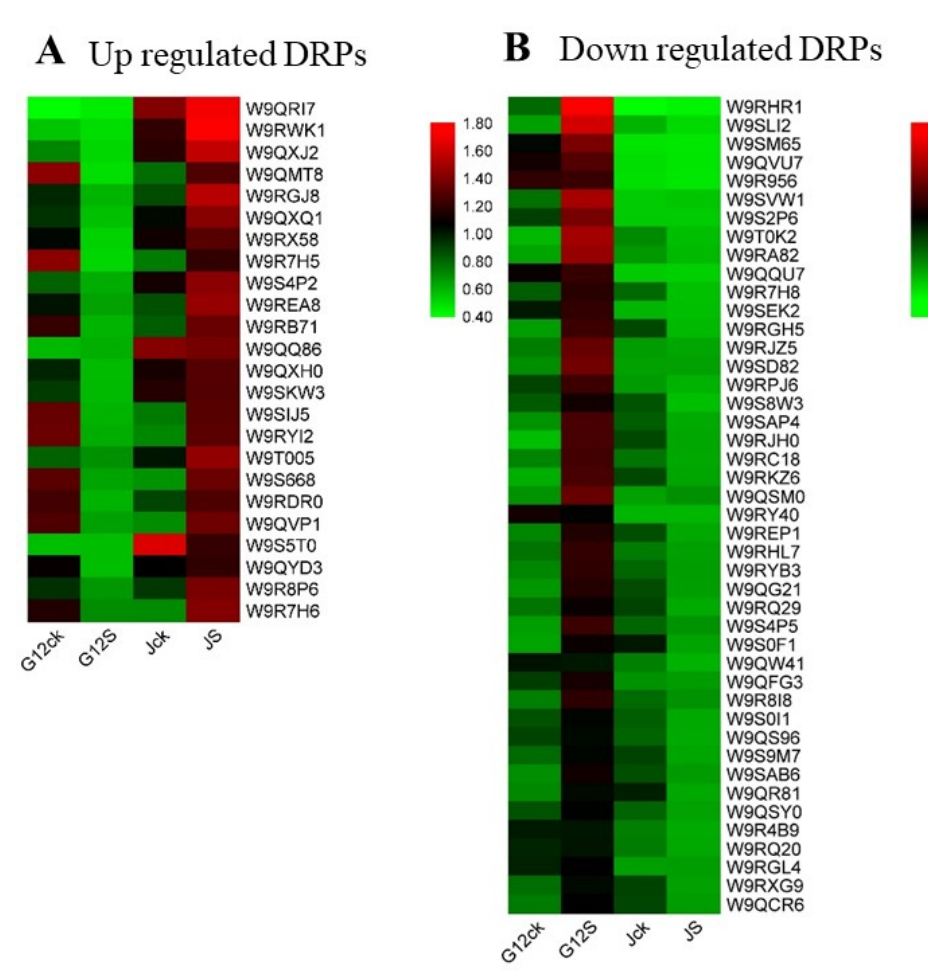
Figure 4. Heatmap of differentially expressed proteins identified in mulberry roots after NaCl treatment. Fold change >1.5. Red represents a high gene expression level and green represents a low gene expression level.